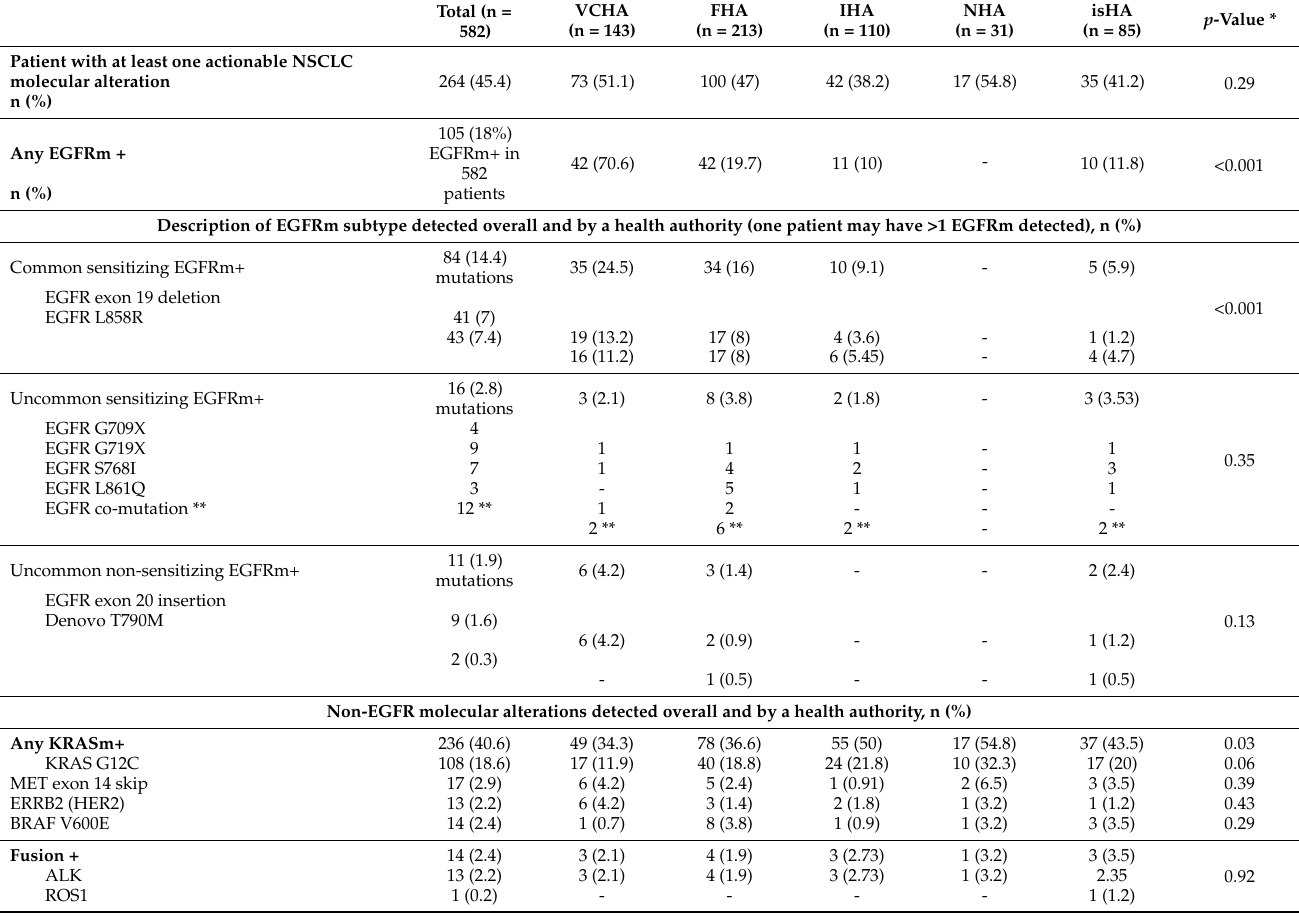
Table 2. Incidences of actionable molecular alterations for the total BC Cancer NSCLC cohort (May 2020 to June 2021) and health authority